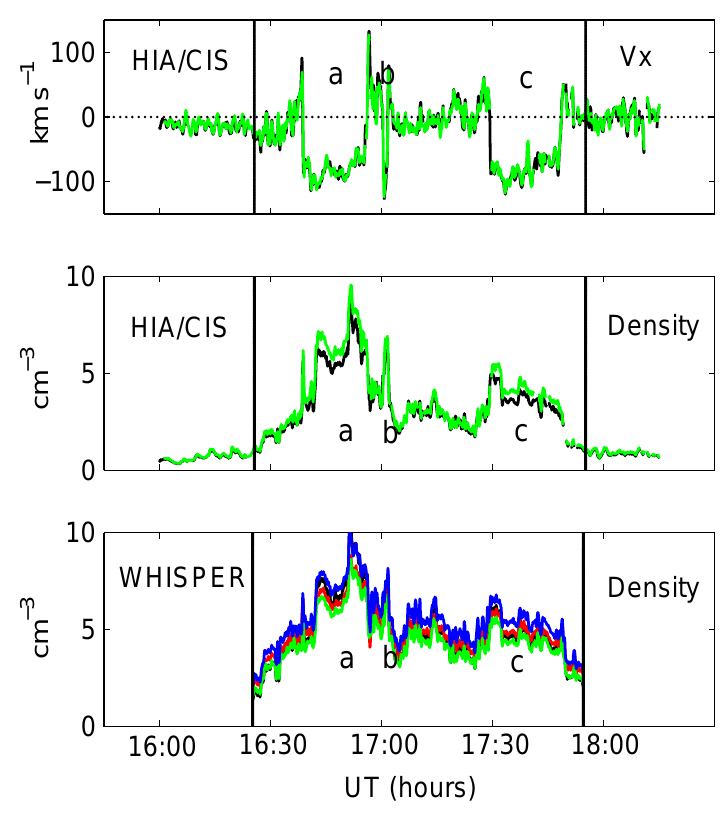
Fig. 7. X-component of the ion velocity (top panel) and ion density (middle panel) from HIA/CIS on Cluster SC1 (black) and SC3 (green), and electron density (bottom panel) from WHISPER on SC1 (black), SC2 (red), SC3(green) and SC4 (blue) during 16:00–18:15 UT on 18 April 2002. The time interval (16:25–17:55 UT) between the vertical lines corresponds to the period of interest; a, b and c are anti- sunward ion flow